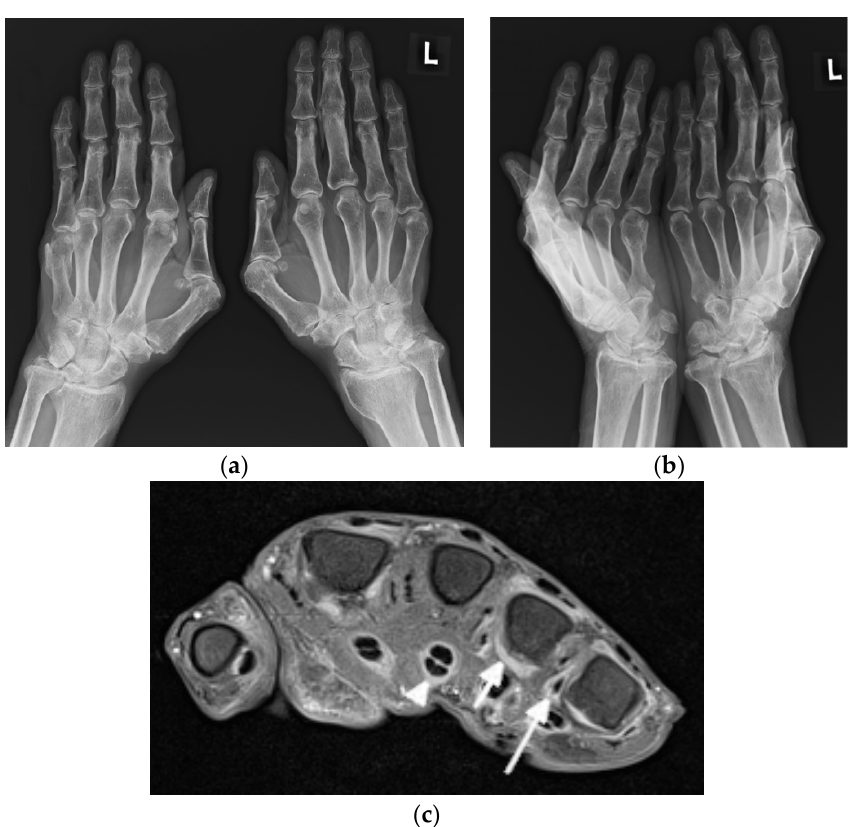
Figure 2. A 63-year-old male with systemic lupus erythematosus and Jaccoud’s deformities on clinical examination. ( a ) Posterior–anterior and ( b ) oblique radiographs of the bilateral hands show ulnar deviation of the lesser finger phalanges of the right hand, with malalignment of the 3rd–5th digits proximal interphalangeal (PIP) joints that are more apparent in ( b ). They also show contracture at the 3rd PIP joint of the left hand, osteoarthritis of the bilateral wrists and scattering of the metacarpophalangeal (MCP) joints, bilateral positive ulnar variance, and posttraumatic deformities of the bilateral distal radial metaphysis and of the distal right 5th metacarpal. ( c ) Axial postcontrast T1-weighted magnetic resonance image with fat saturation of the right hand shows MCP joints 2, 4, and 5 synovitis (short arrow pointing to MCP 4), MCP 2, 4, and 5 capsular enhancement (long arrow pointing to MCP 5), and 2–5 flexor tendons tenosynovitis (arrowhead pointing to middle finger flexor tendon sheath).